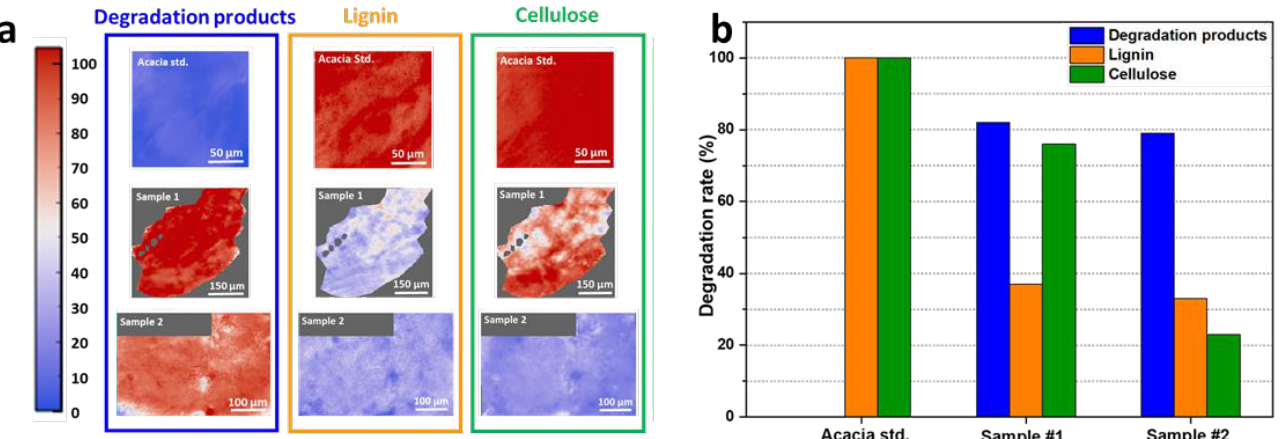
Figure 8. ( a ) FPA mosaic of samples # 1 and #2 (archaeological wooden samples) and Acacia standard (#3). The FPA map scale (blue: low intensity; red: high intensity) was calibrated to the highest mean values of integration recorded. The false-colour map was obtained by integrating the oxalate band in the range 1350 – 1300 cm − 1 . ( b ) Average spectrum of oxalates extracted from the hot spots highlighted in the false-colour FPA map (panel ( a )). It was compared with a Weddellite reference spectrum from the Kimmel Center for Archaeological Science Infrared Standards Library, Weizmann Institute of Science (Rehovot, Israel).